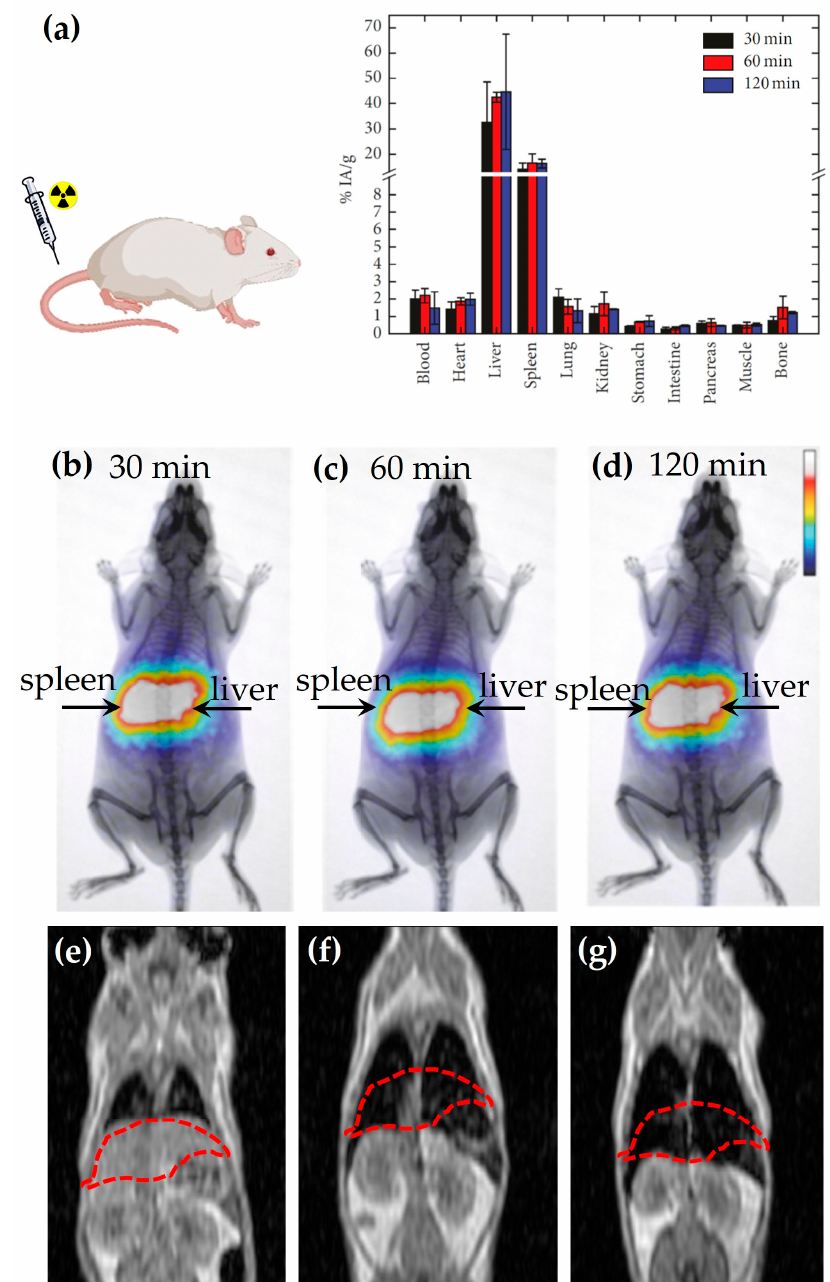
Figure 6. ( a ) In vivo biodistribution study of 68 Ga based RIONs in normal Swiss mice performed at 30, 60, and 120 min p.i. [58]; ( b – d ) Representative images of a mouse obtained by PET imaging at ( b ) 30 min, ( c ) 60 min, ( d ) 120 min p.i. [58]; T 1 -weighted MR image of mice injected via the tail vein with RIONs at a final concentration of ( e ) 0.01 mg/mL; ( f ) 0.1 mg/mL; ( g ) T 1 -weighted MR image of a mouse injected via the tail vein with non-radiolabeled IONs at a final concentration of 0.3 mg/mL. The MRI imaging has been performed at 6 h p.i. [10].